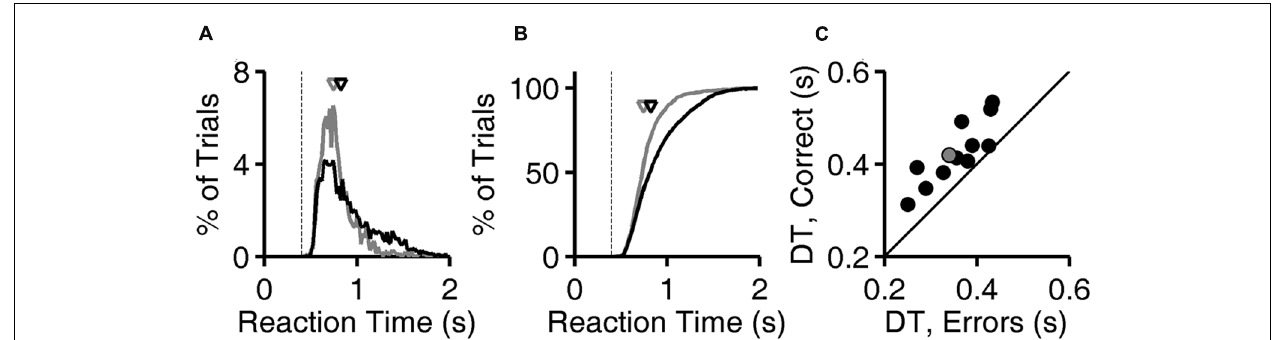
FIGURE 2 | Longer latencies in correct trials. (A) Distribution of reaction times for error trials (gray) and correct trials (black) for exemplar discriminations for one subject (same subject as Figure 1D ). Normalized probability distributions are shown, but there were about five times more correct trials than error trials. Arrows indicate median latencies of the distributions (0.743 s for errors, 0.823 s for correct responses). Dashed line is the minimum reaction time this